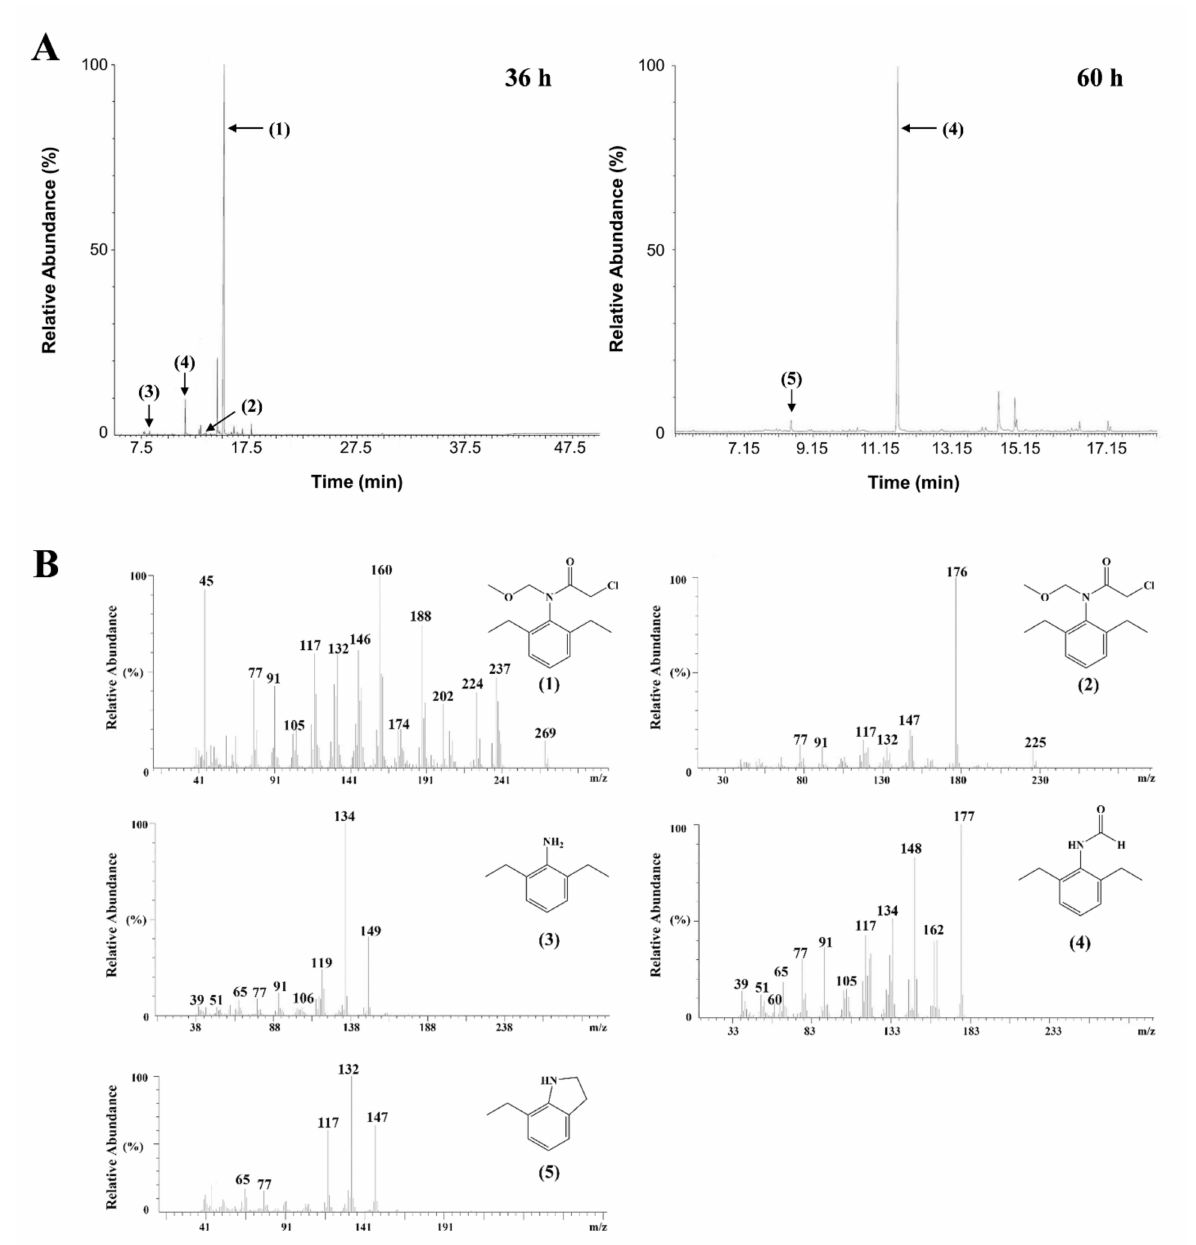
Figure 5. ( A ) Gas chromatogram spectrum of the extract from 36 h and 60 h of cultures. ( B ) Identifi- cation of metabolites in the degradation of alachlor by GC-MS. (1) alachlor ( m / z 269); (2) 2-chloro- N - (2,6-diethylphenyl) acetamide ( m / z 225); (3) 2,6-diethylaniline ( m / z 149); (4) N -(2,6-diethylphenyl) formamide ( m / z 177); and (5) 7-ethylindoline ( m / z